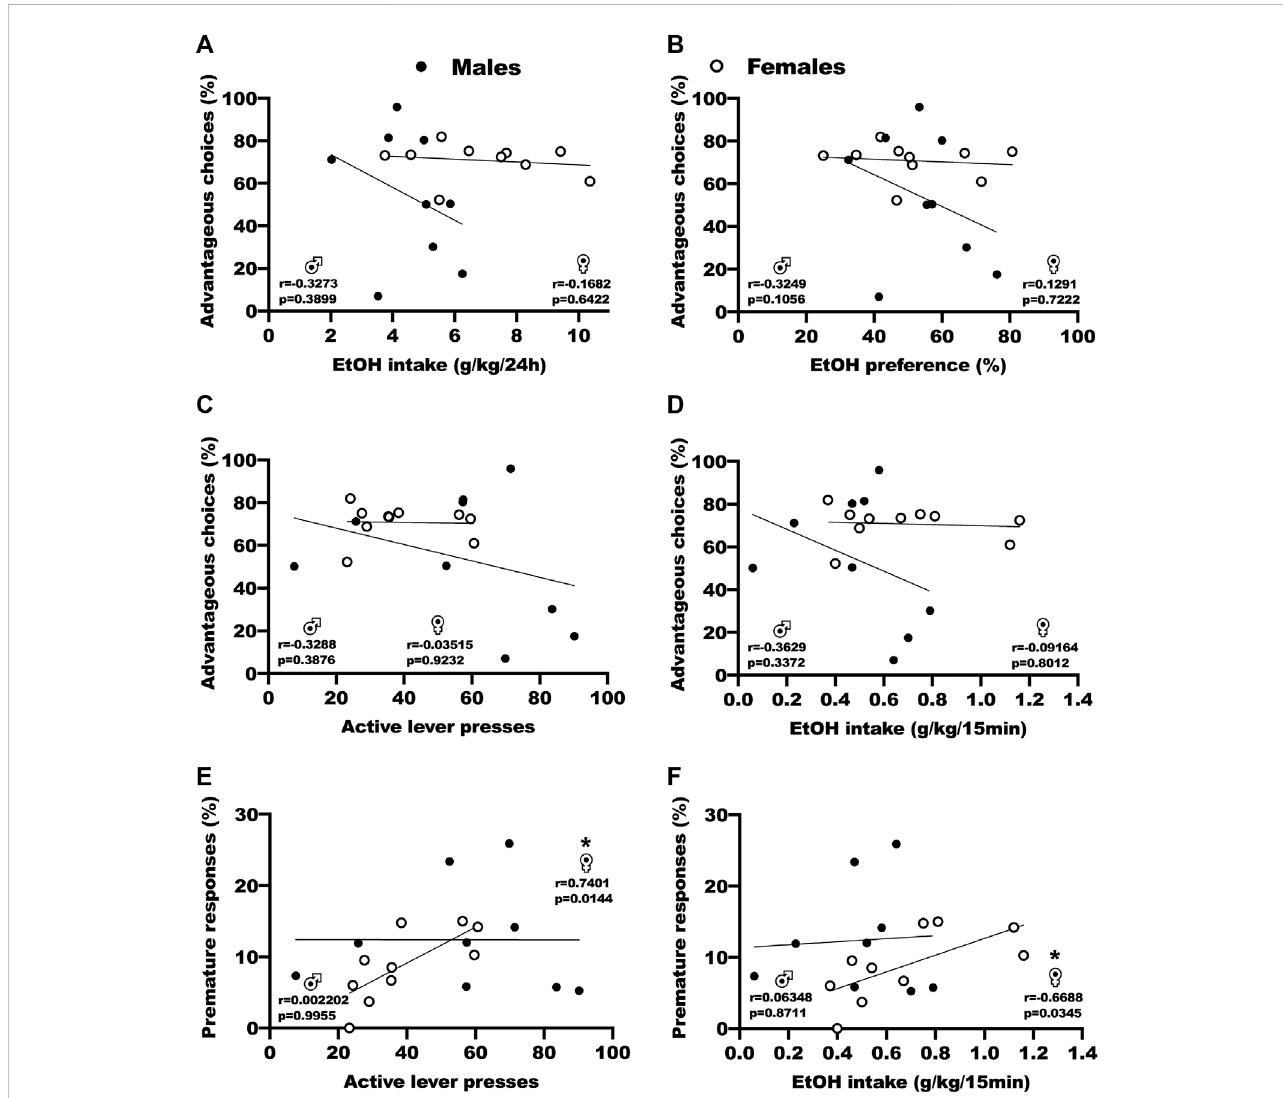
FIGURE 3 Correlation analysis of the relation betweenbaseline DM abilities and ethanol consumption. (A) No correlation between advantageous choices (P1 + P2) during baseline RGT sessions and ethanol intake by weight during the last IA2BC session. Results are expressed as the percent of choices in the P1 and P2 options versus the ethanol intake by weight during the 24 h sessions (g/kg/24 h). (B) No correlation between advantageous choices (P1 + P2) during baseline RGT sessions and ethanol preference during the last IA2BC session. Results are expressed as the percent of choices in the P1 and P2 options versus the proportion of ethanol consumed over total fl uid consumed. (C) No correlation between advantageous choices (P1 + P2) during baseline RGT sessionsandactiveleverpressesduringthelast5stableoperantself-administrationFR315 minsessions.Resultsareexpressedasthepercentofchoicesinthe P1 and P2 options versus the number of presses on the active lever during the 15 min sessions. (D) No correlation between advantageous choices (P1 + P2) during baseline RGT sessions and ethanol intake by weight during the last 5 stable operant self-administration FR3 15 min sessions. Results are expressed as thepercentofchoicesintheP1andP2optionsversustheethanolintakebyweightduringthe15 minsessions(g/kg/15 min). (E) Positivecorrelationinfemales, butnotmales,betweenprematureresponsesduringbaselineRGTsessionsandthenumberofpressesontheactiveleverduringthelast5stableoperantself- administration FR3 15 min sessions. Results are expressed as the percent of premature responses versus the number of presses on the active lever during the 15 min sessions. (F) Positive correlation in females, but not males, between premature responses during baseline RGT sessions and ethanol intake by